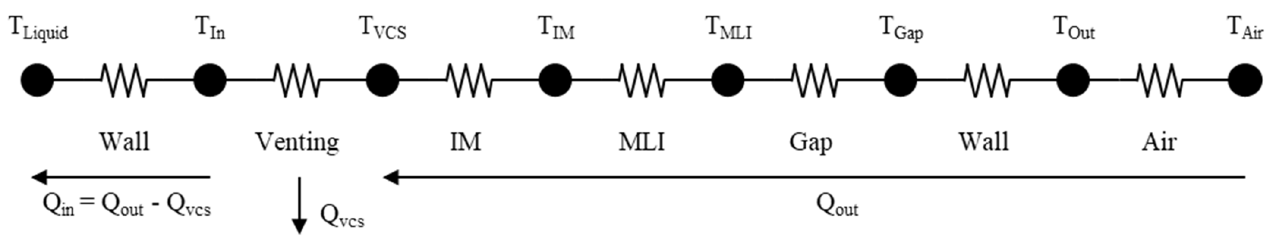
Figure 5. The example of thermal equilibrium and temperature nodes [31–33].